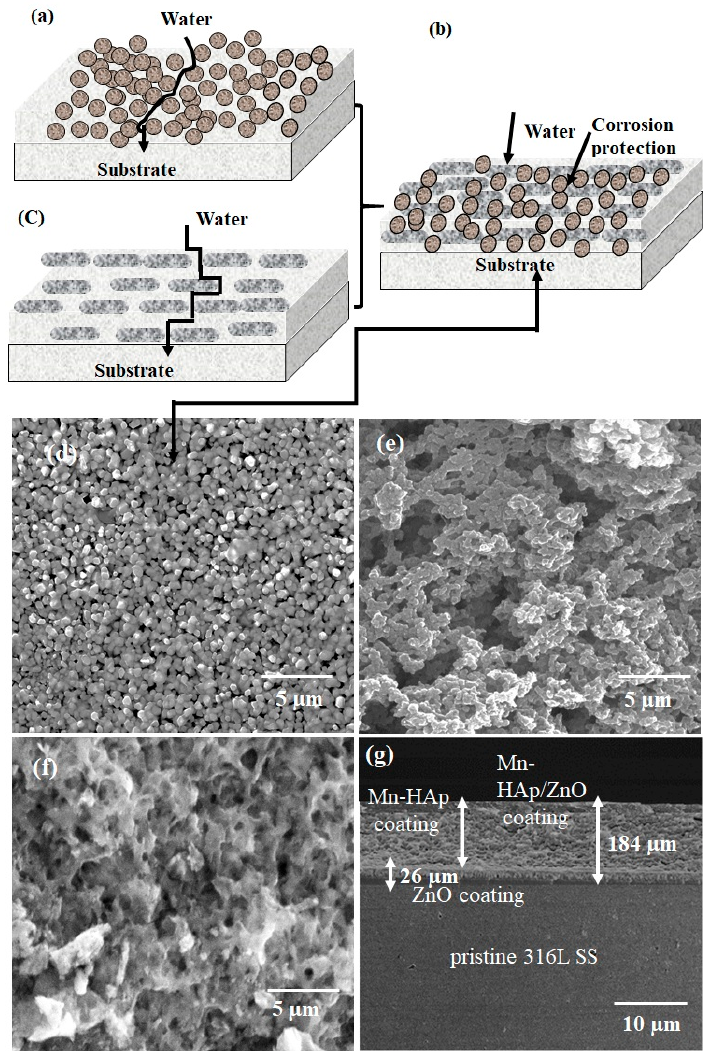
Figure 1. ( a – c ) Spherical, lamellar, and combined zinc oxide (ZnO) structure coated stainless steel (316L SS) substrate. Field emission scanning electron microscopy (FESEM) images of ( d ) ZnO, ( e ) porous manganese substituted hydroxyapatite (Mn-HAp), and ( f ) Mn-HAp/ZnO bilayer coatings on 316L SS and ( g ) cross-sectional FESEM image of Mn-HAp/ZnO bilayer coating on 316L SS. 2.2. Transmission Electron Microscopy (TEM), High-Resolution Transmission Electron Microscopy